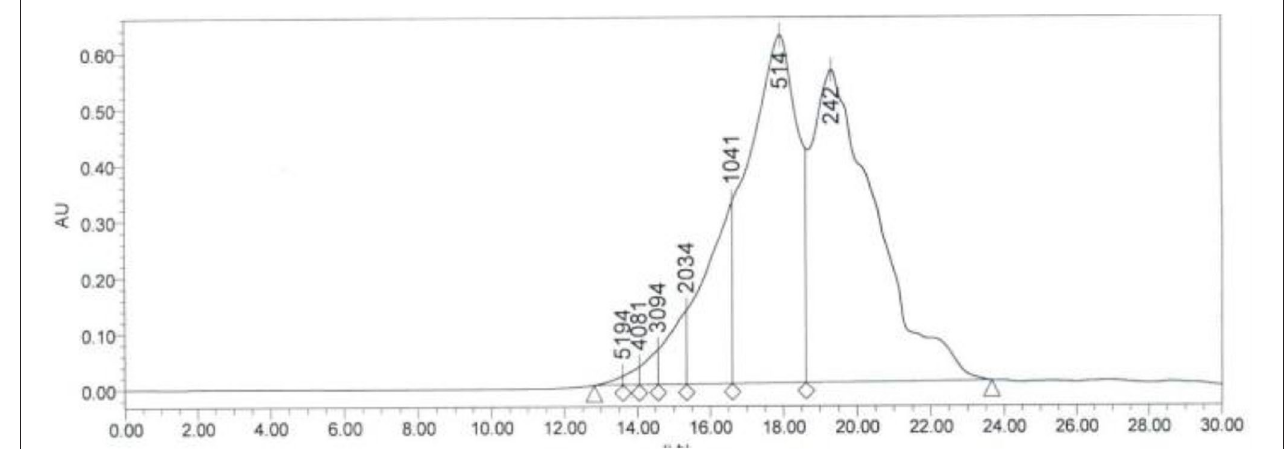
FIGURE 1 | The molecular weight distribution of SCIP investigated by high-performance liquid chromatography